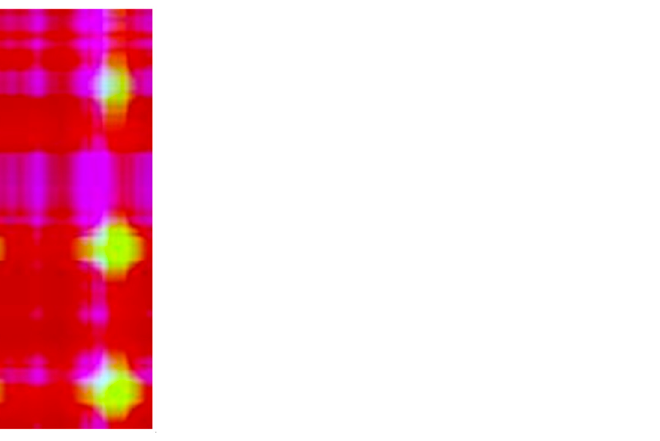
Figure 9. GASF matrices chosen to create RGB images. Red—moment; green—force; blue—sound